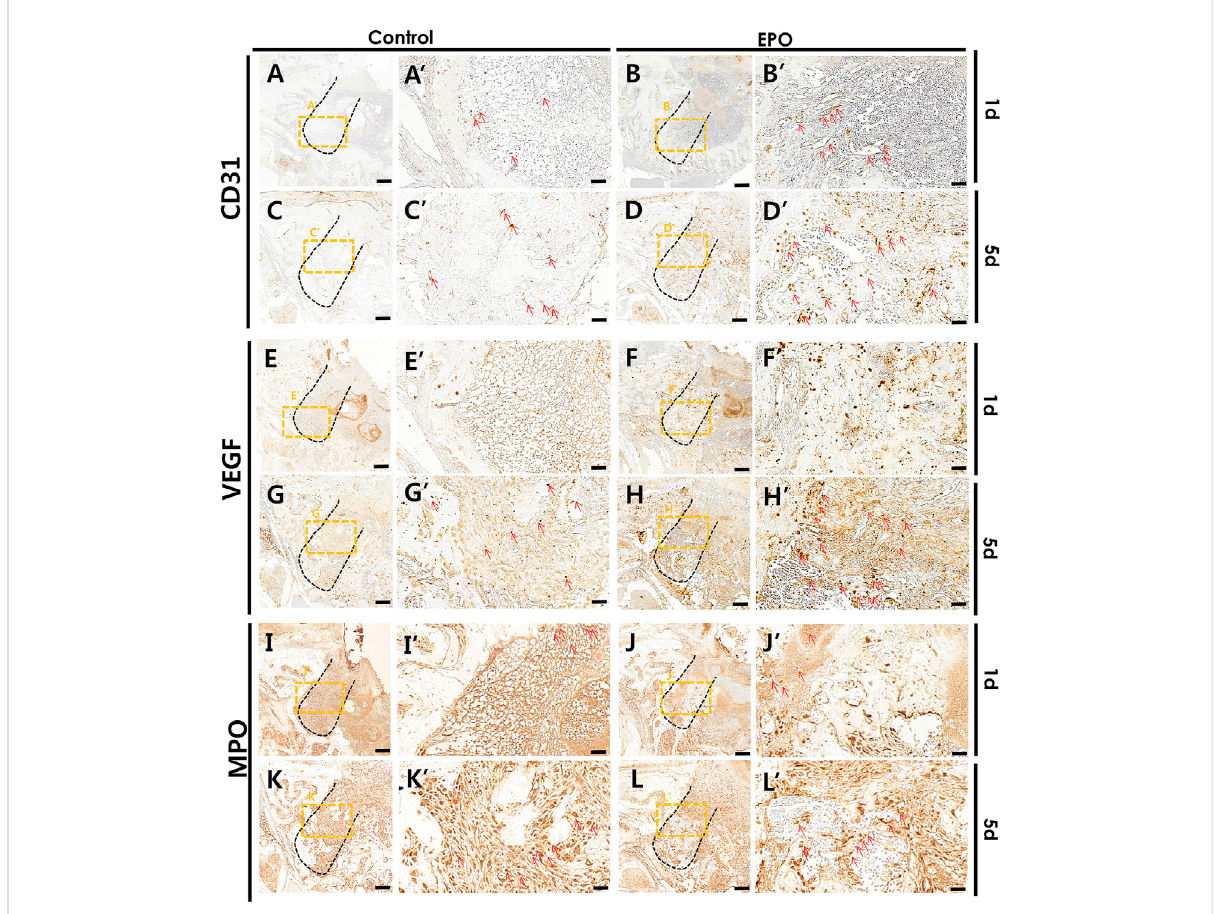
FIGURE 4 Representative photomicrographs of alveolar tissue sections stained with vascular endothelial markers and the in fl ammatory marker in the control group (A,C,E,G,I,K) and EPO group (B,D,F,H,J,L) at 1 and 5 days. On day 1, the EPO group show stronger expression of cluster of differentiation31(CD31)andvascularendothelialgrowthfactor(VEGF)intheentireextractionsocket,especiallyintheapicalandmiddleone-thirdof the regions compared to the control (A 9 ,B 9 ,E 9 ,F 9 ) . On day 5, the localization patterns are intensi fi ed in the EPO group compared to those observed on day 1 (B 9 ,D 9 ,F 9 ,H 9 ) . The EPO group also show a much stronger localization pattern, especially in the coronal 1/3 compared to that in the apical1/3andmiddle1/3regions (B 9 ,D 9 ,F 9 ,H 9 ) .Incontrast, theEPOgroupshoweddecreasedimmunolocalizationofmyeloperoxidase(MPO)inboth 1- and 5-day specimens (I 9 ,J 9 ,K 9 ,L 9 ) . Red arrows point to positive cells against CD31 (A – D) , VEGF (E – H) , and MPO (I – L) . Scale bar: X = 100 μ m, X ’ = 20 μ m (X ′ is higher magni fi cation of